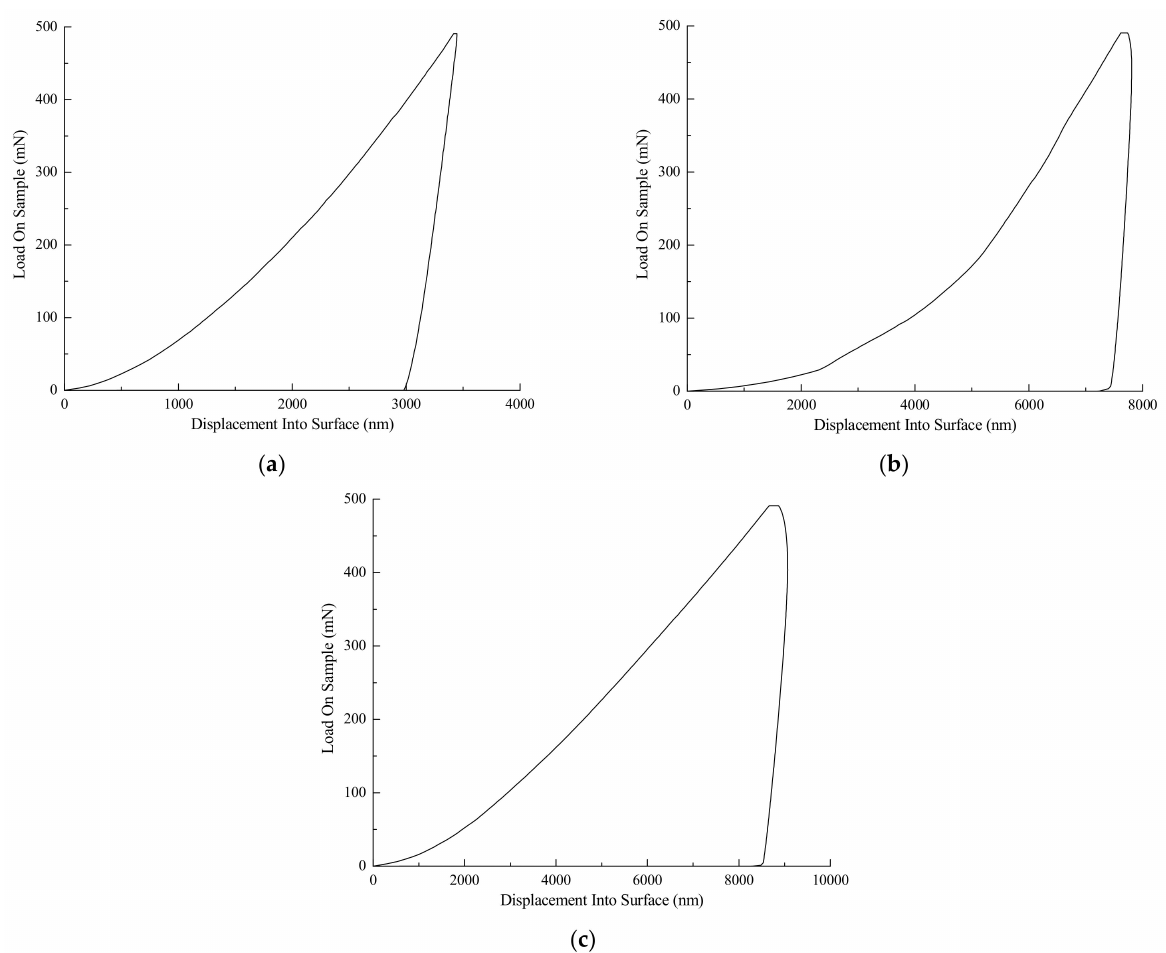
Figure 5. The nanoindentation curve: ( a ) the substrate; ( b ) Babbitt B83; ( c ) the running-in coatings of specimen 2.